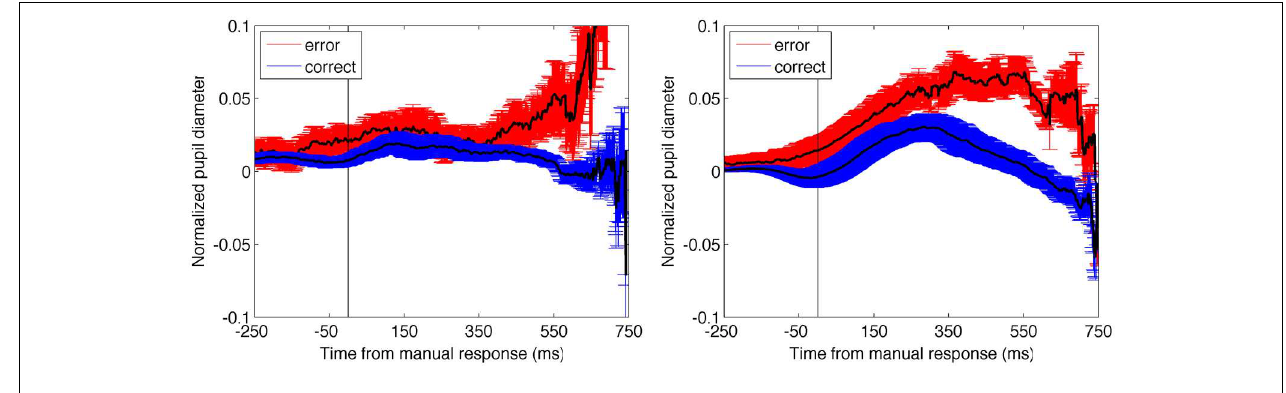
FIGURE 6 | Pupil diameter time-locked to the manual response as a function of trial accuracy. Error bars are standard error of the mean. In both experiments, the results from the permutation analysis were the same